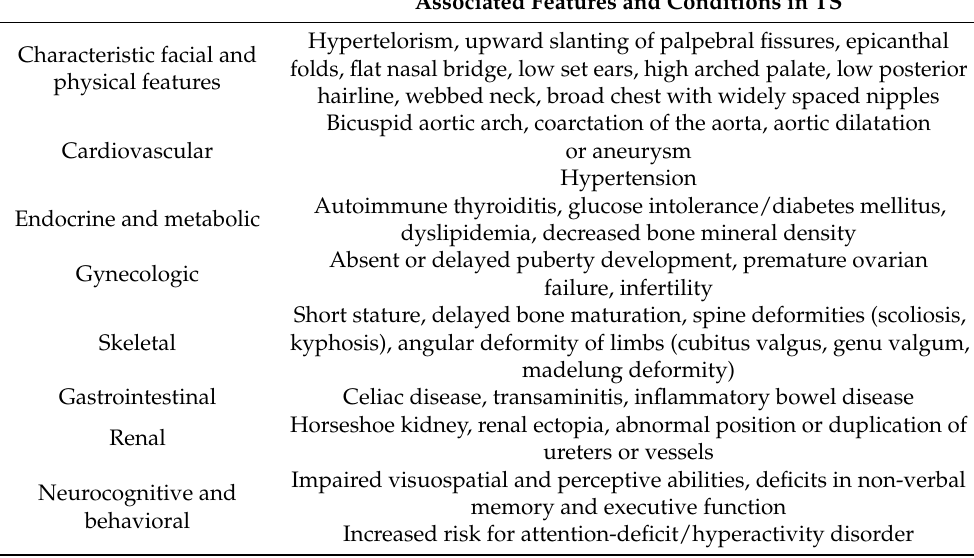
Associated Features and Conditions in